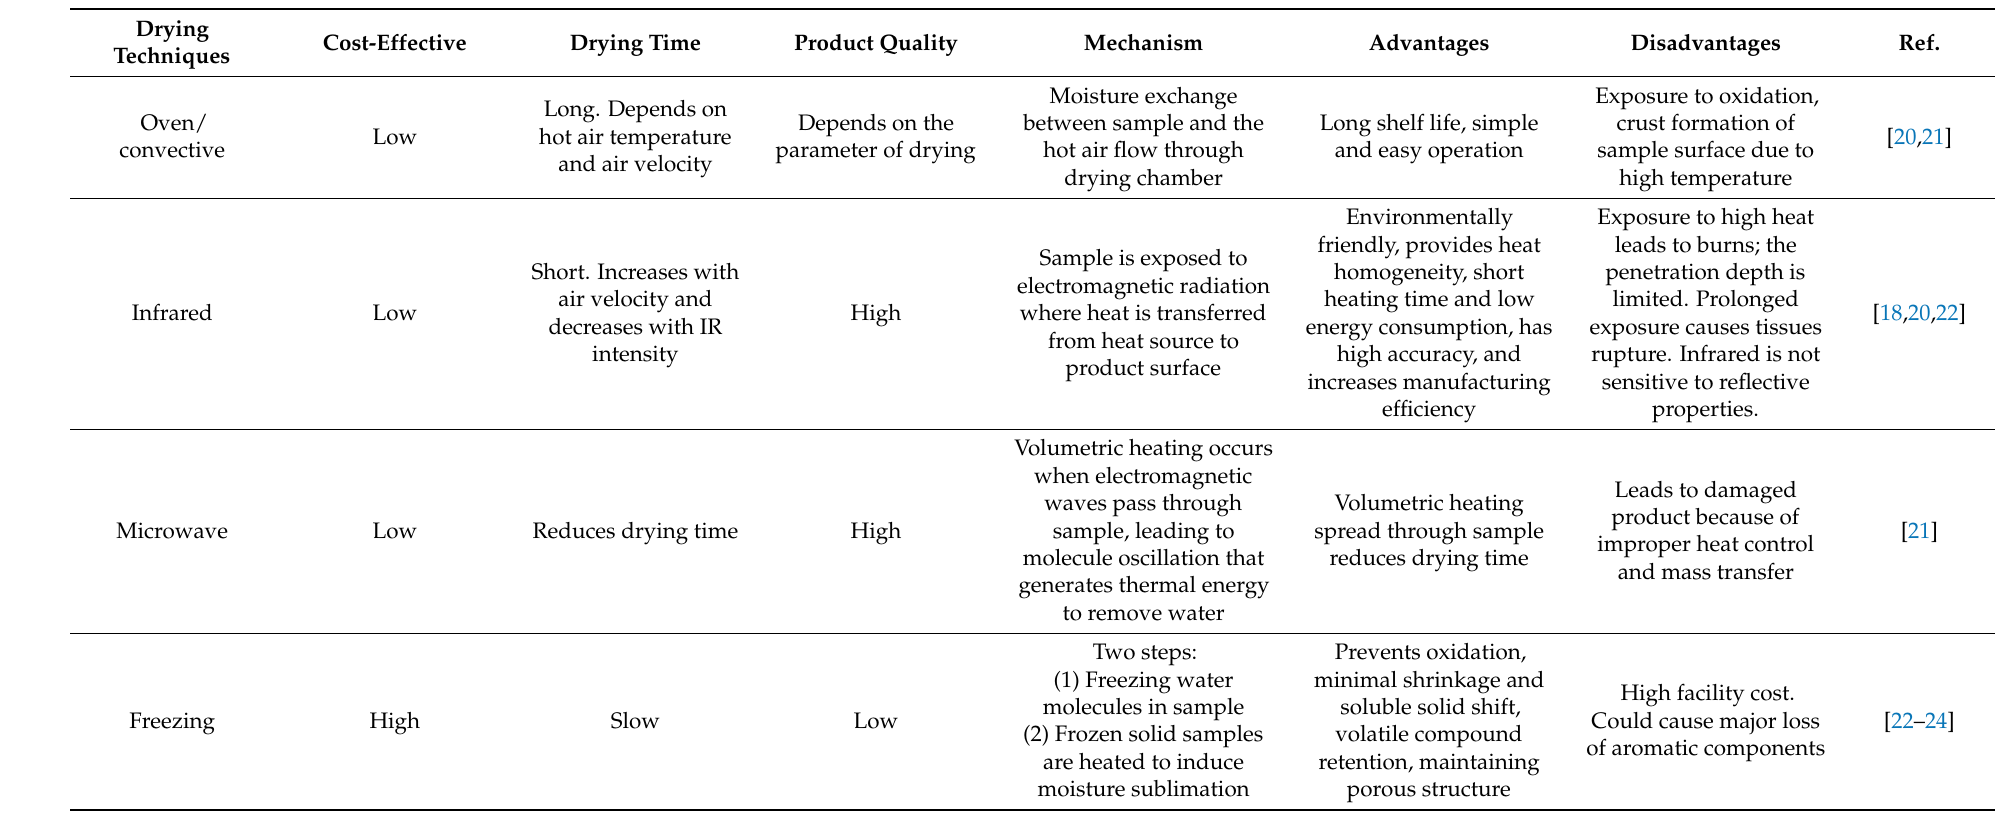
Table 1. Comparison between drying